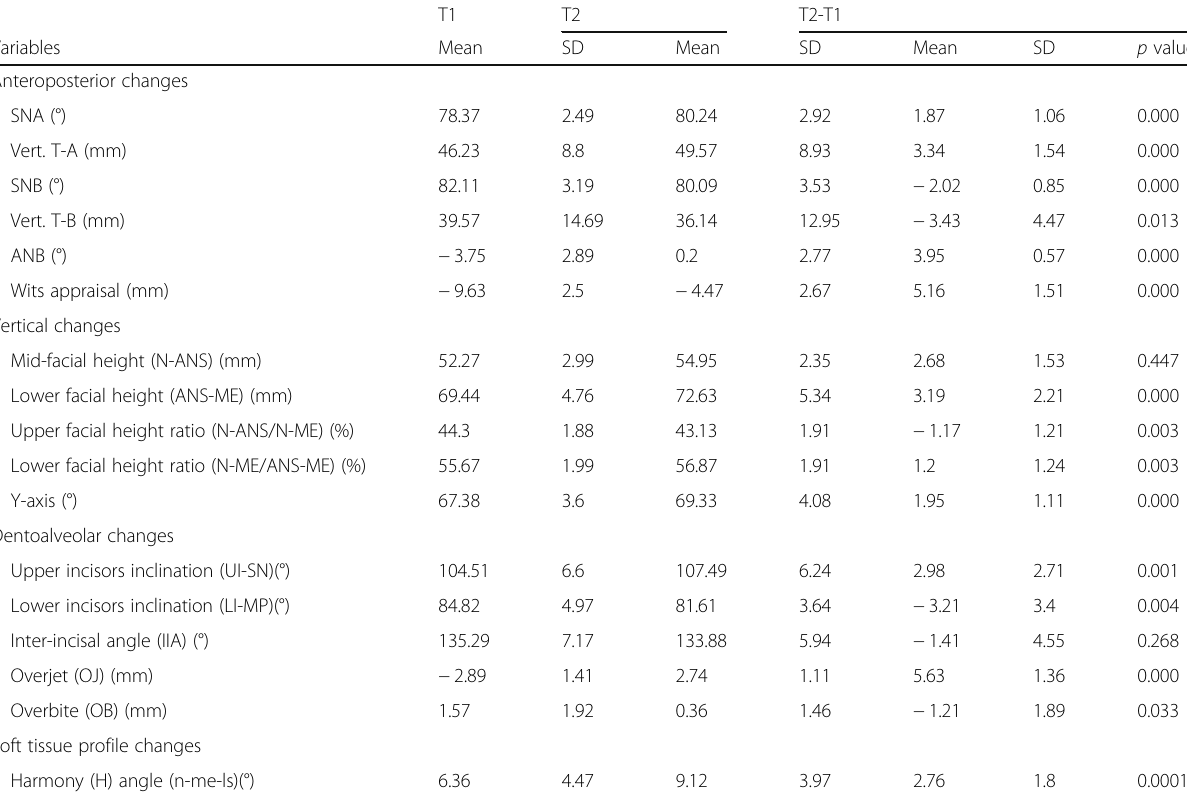
Table 1 Skeletal, dental, and soft tissue changes from T1 to T2 T1 T2